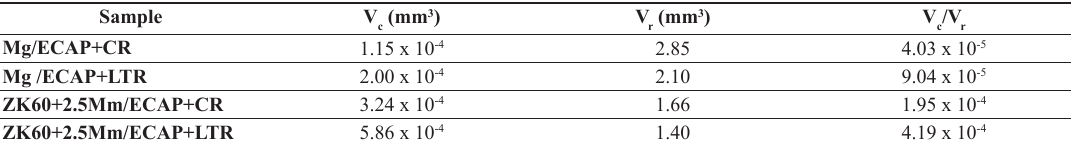
) as determined by microtomography reconstructions for pure r